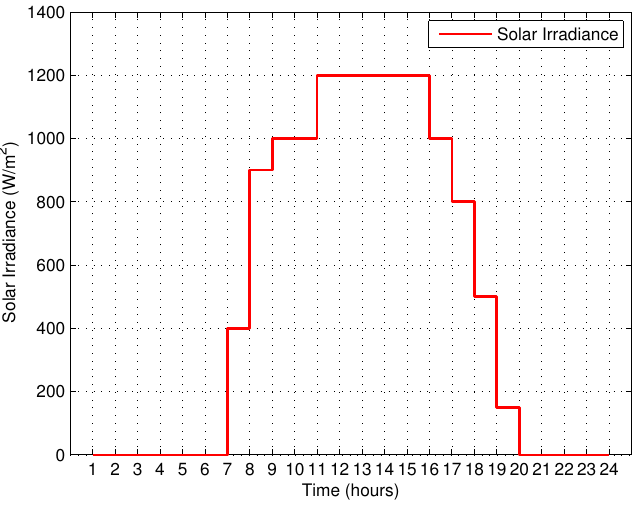
Figure 5. Solar irradiance.